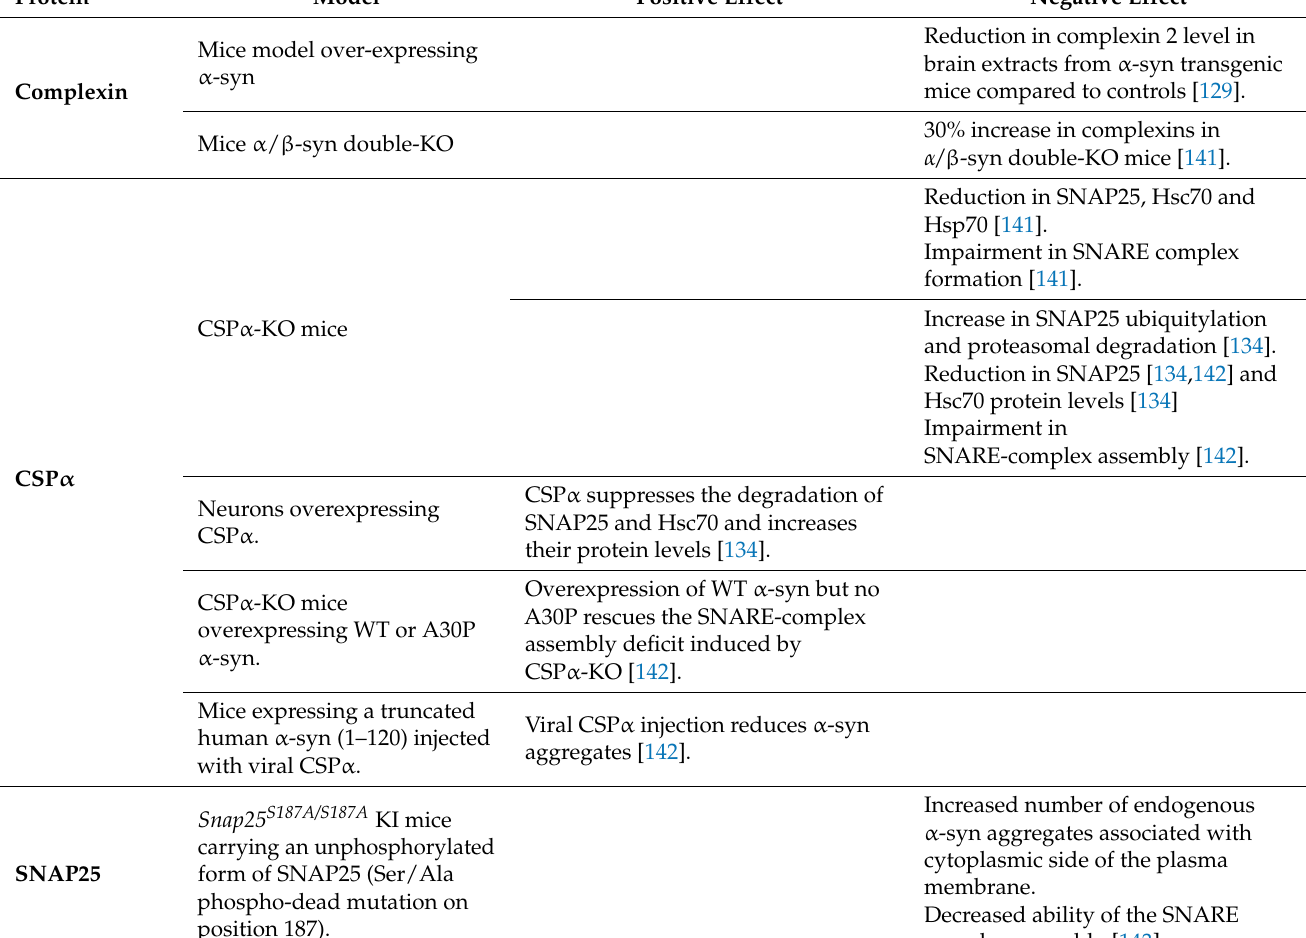
Table 3. Synaptic proteins and their relationship to α -synuclein ( α -syn) aggregates and vesicular alterations. The first column mentions the synaptic proteins while the second column mentions the models in which these proteins were studied. The third and fourth columns describe positive or negative effects observed on α -syn and vesicular functions, respectively.